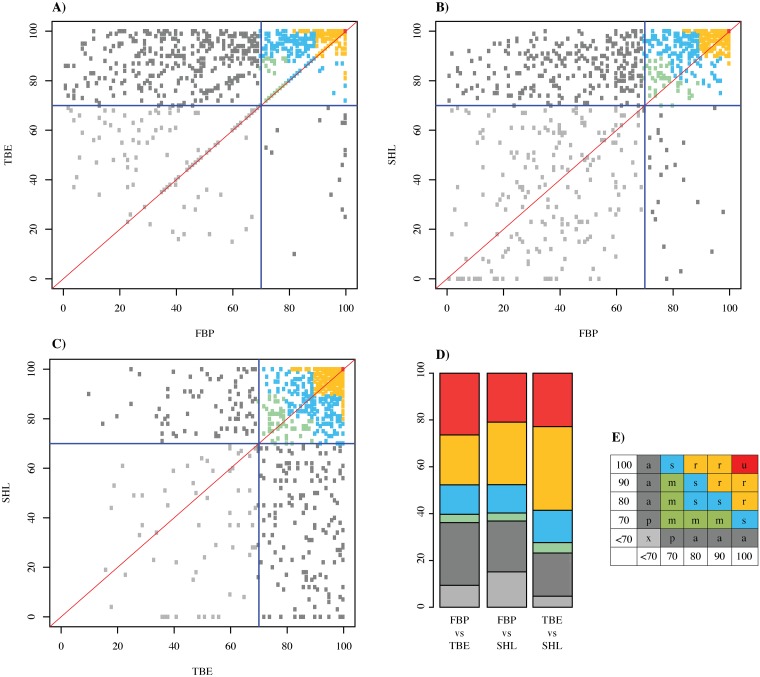
Scatterplots comparing support metrics for internal branches in the
Maximum likelihood species-level phylogeny of Colubroides.A) TBE and FBP B) SHL and FBP C) SHL and TBE, D) Histogram showing the
proportion of each category of joint support in each comparison of support
metrics, E) Categories of joint support.